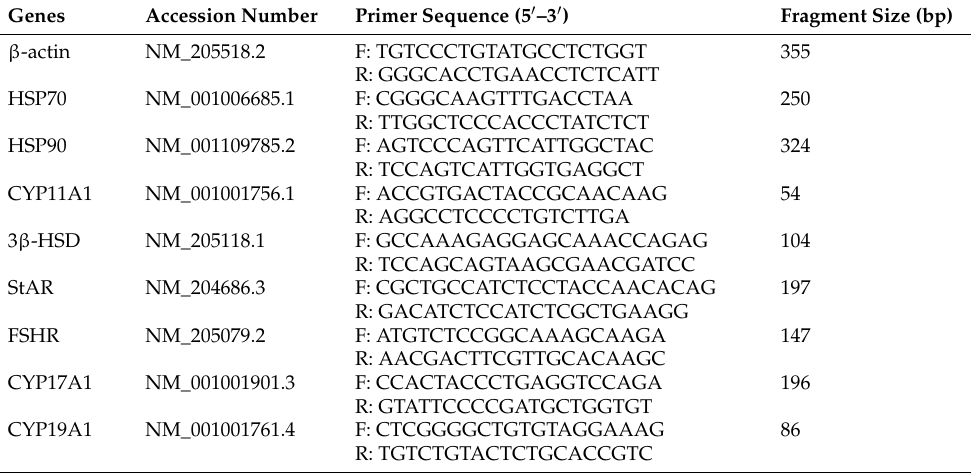
Table 1. The primer sequences for qPCR.